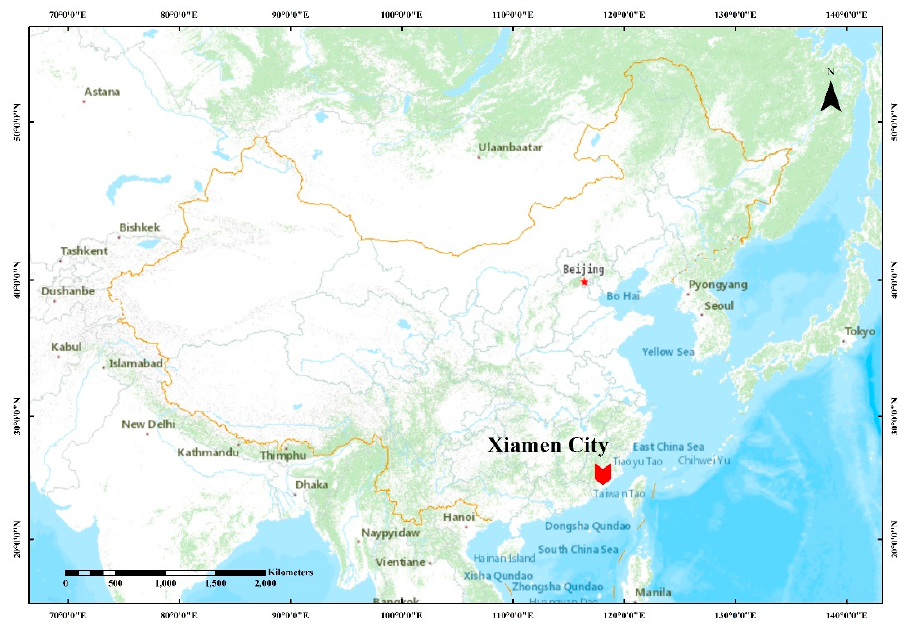
Figure 1. The location of study area.